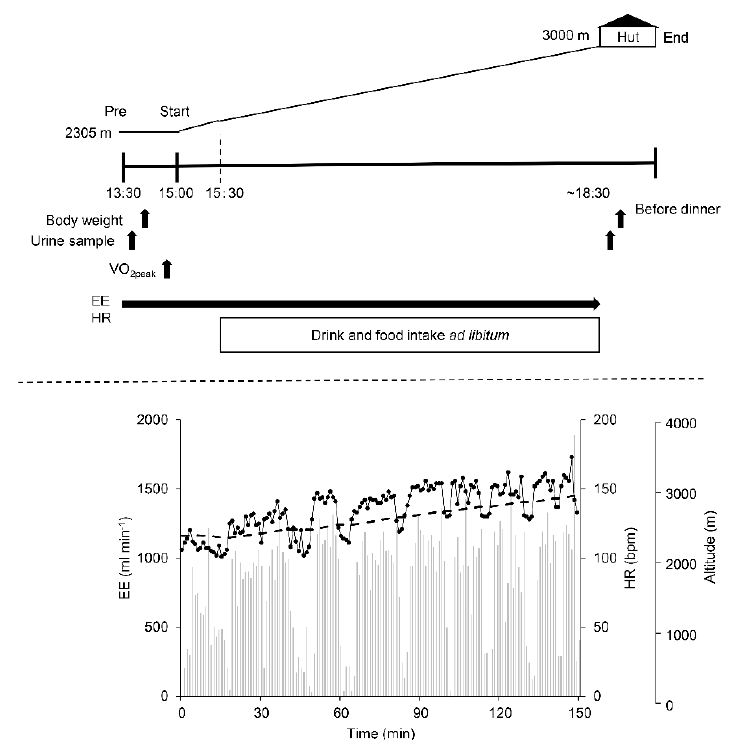
Figure 2. Upper panel: the profile of this study. Participants consumed TW or CE+HCO 3 beverage ad libitum throughout the mountain trekking except for the first 30 min before beginning the trekking, during which time their body weight and peak aerobic capacity were measured. The measurements are shown in the procedure of the text. Lower panel: typical examples of heart rate (HR), energy expenditure per min (EE) and altitude. Black line graph indicates HR, gray bar graph indicates EE, and gray dotted line indicate altitude.